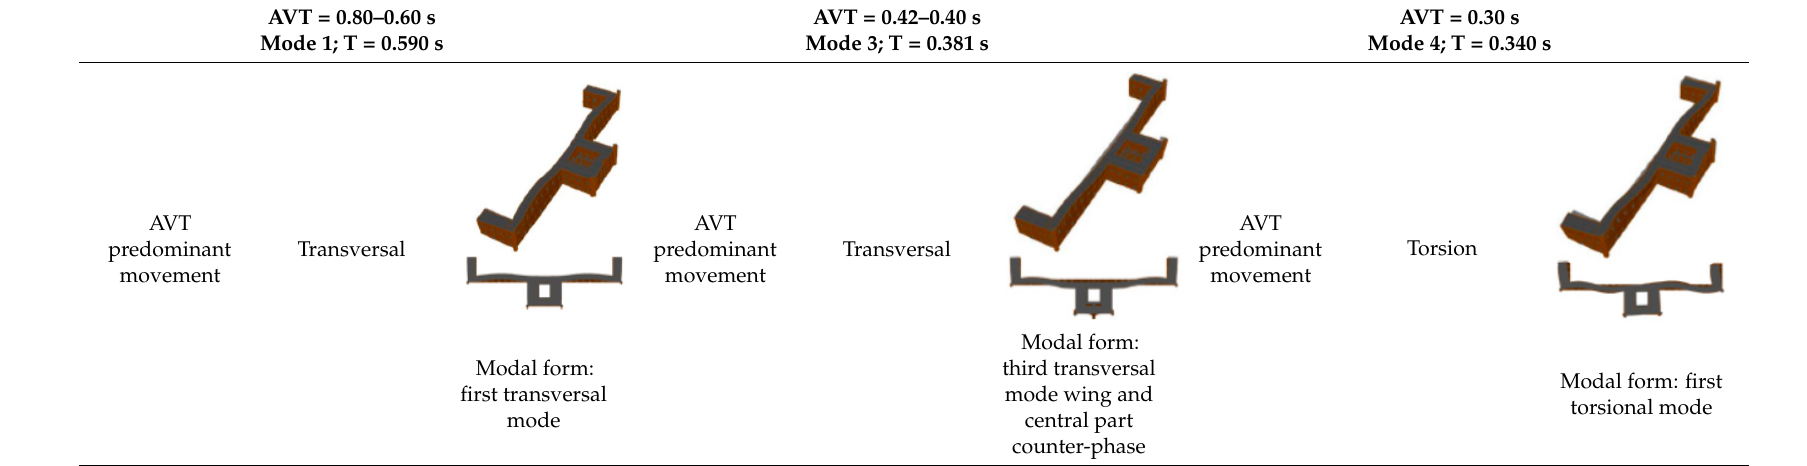
Table 7. Numerical model and ambient vibration tests (AVT) periods and modal shapes.